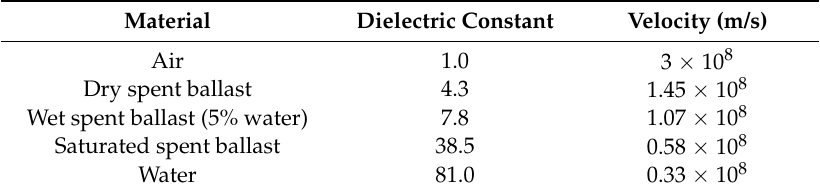
Table 1. Dielectric constant and the velocity of the signal in various material, data measured by [43]. Material Dielectric Constant Velocity (m/s) Air 1.0